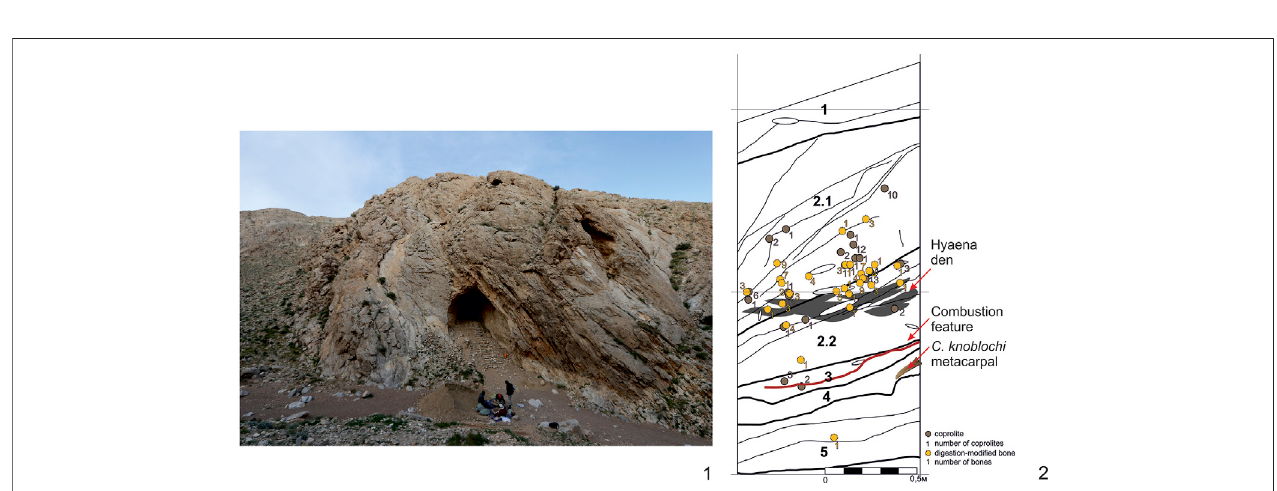
FIGURE 9 | Evidence of human-animal interaction at Tsagaan Agui Cave, Gobi Altai Region, Mongolia: 1 – view of the cave; 2 – cross-section of Pit 2021/2 indicating hyaena dens, coprolites and the position of C. knoblochi metacarpal in Layer 4.